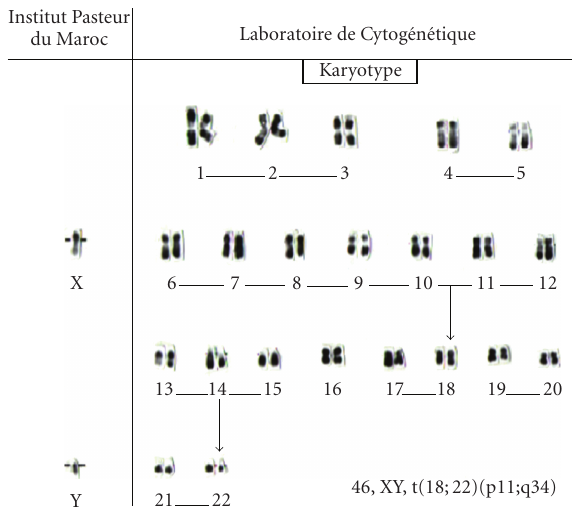
Figure 1: Karyotype from a bone marrow metaphase of the patient showing 46,XY,t(18;22)(p11;q11). The arrows indicate the impli- cated chromosomes.